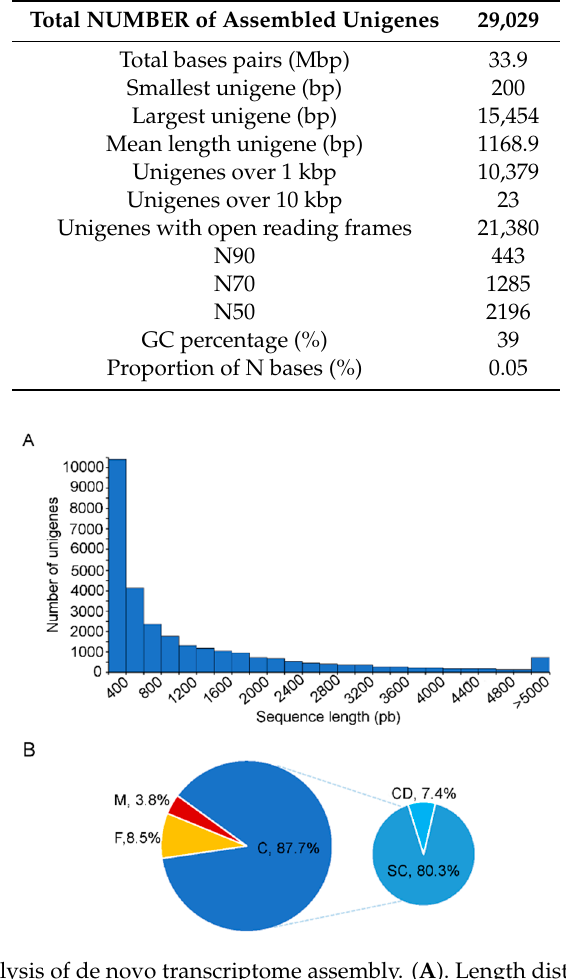
Figure 1. Quality analysis of de novo transcriptome assembly. ( A ). Length distribution of assembled unigenes. ( B ). Analysis of transcriptome completeness using Benchmarking Universal Single-Copy Orthologs (BUSCO) software. Pie charts show the percentage of the 1658 single-copy Insecta ortholog genes database (OrthoDB v9) covered by the assembly: C, complete genes found; SC, complete genes found in single-copy; CD, complete genes found in duplicate; F, fragmented genes found; M, missing ortholog genes.